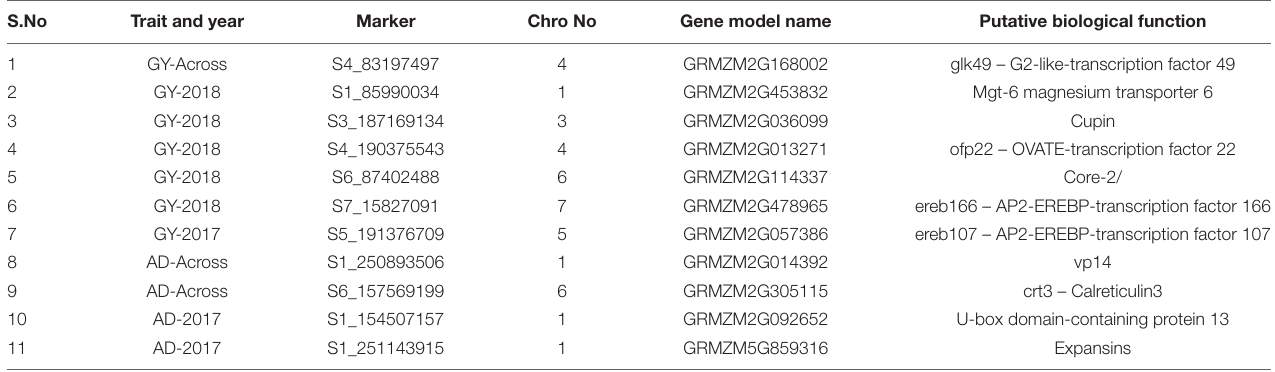
TABLE 4 | List of marker-trait associations within the expression region of genome. S.No Trait and